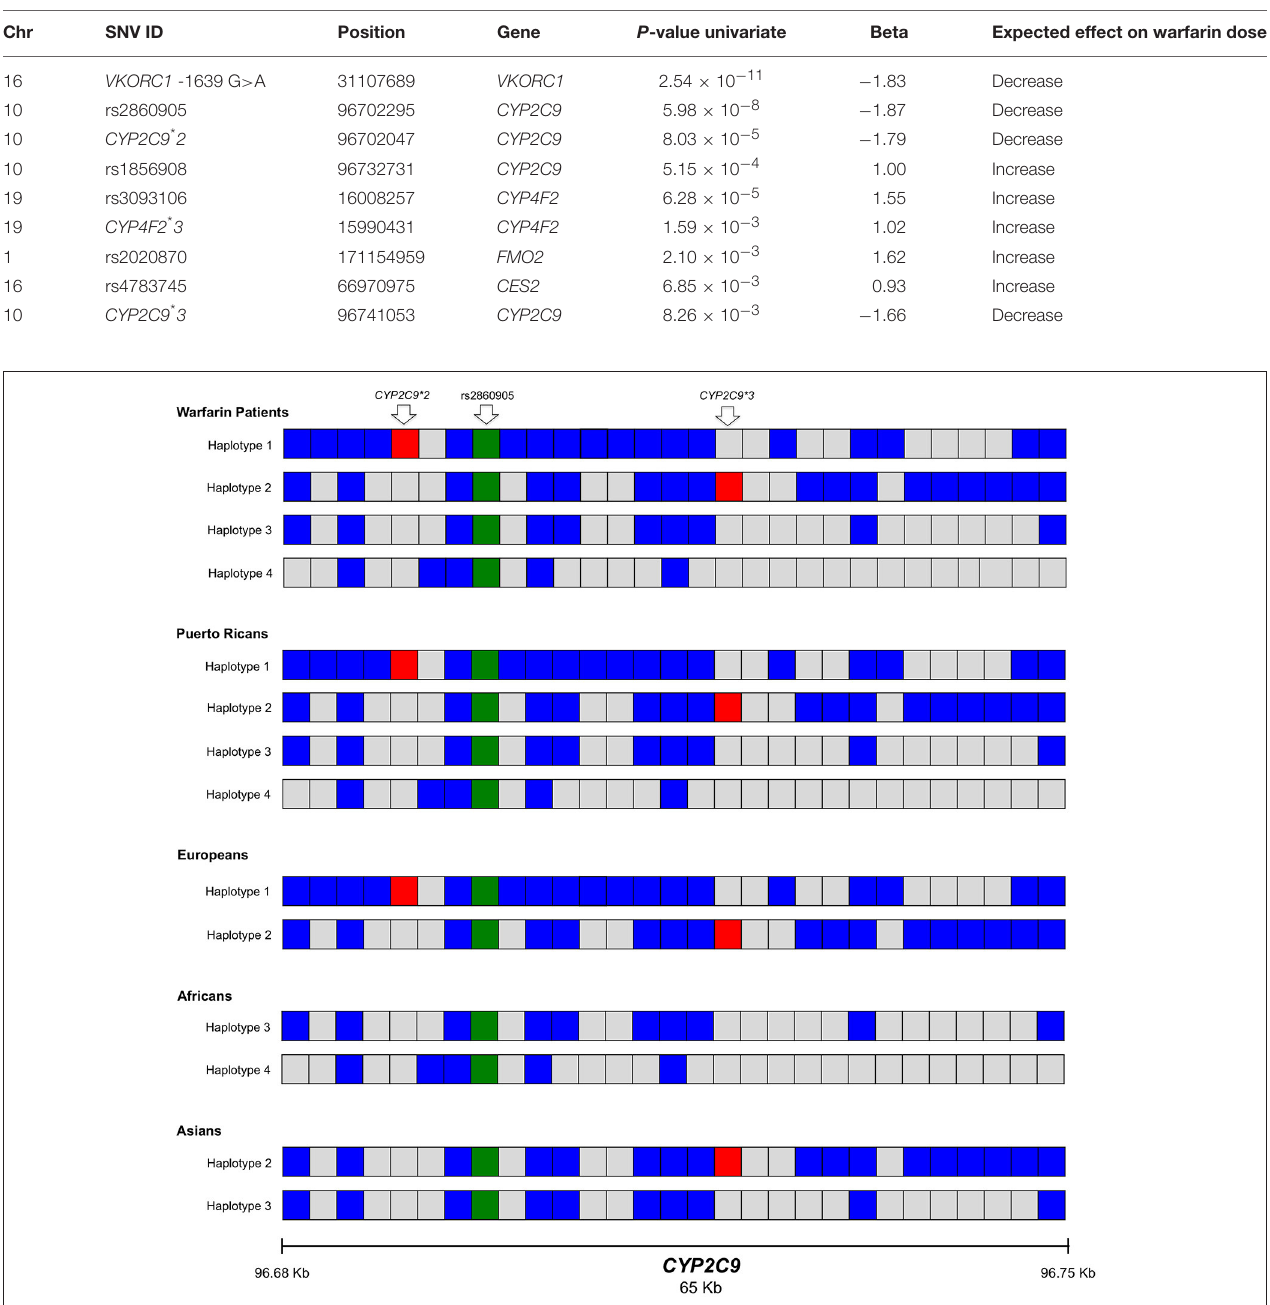
TABLE 4 | Summary of SNVs associated ( P < 0.01) with warfarin dose requirements among Puerto Ricans using case-control association and linear regression analyses. Chr SNV ID